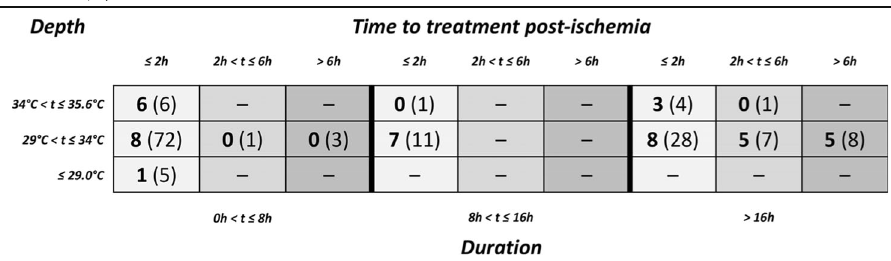
Table 1 STAIR analysis of 102 studies with post-ischemic induction of TTM, which described 147 different regimens. The score is presented as x ( y ), where x is the number of items checked and ( y ) is the number of treatment regimens contributing to that score, where 8 is the highest possible score. Empty boxes were not